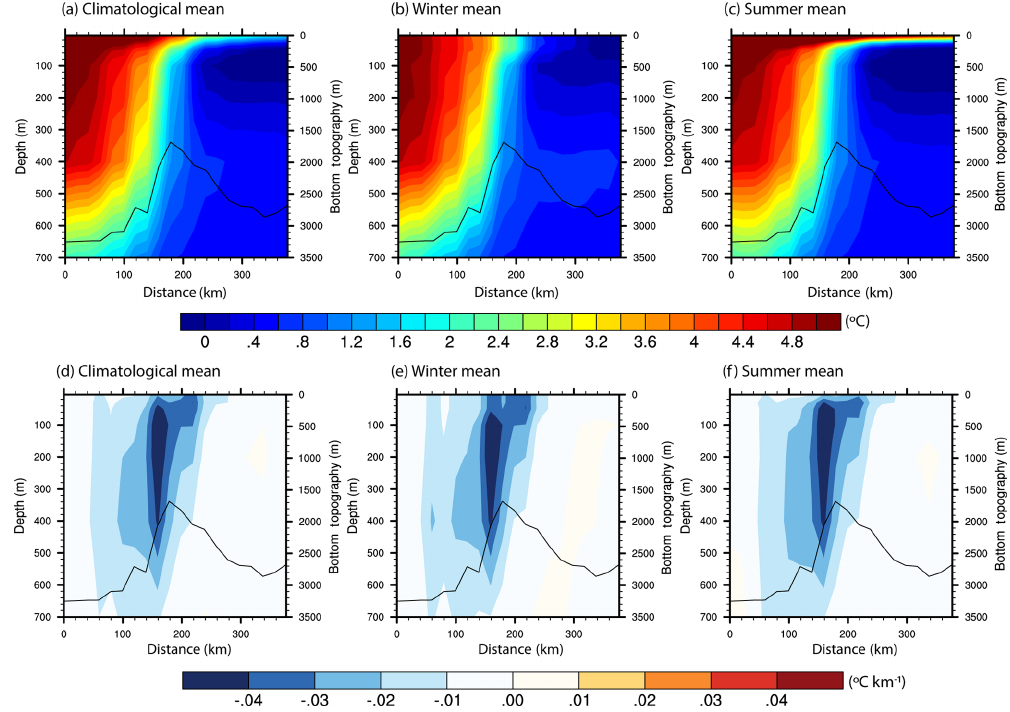
Figure 7. Temperature (a–c) and its horizontal gradient (d–f) along the hydrographic section across the Mohn Ridge. Climatological mean (a, d) , winter (b, e) and summer (c, f) . The bottom topography along the section is indicated by the black contour.